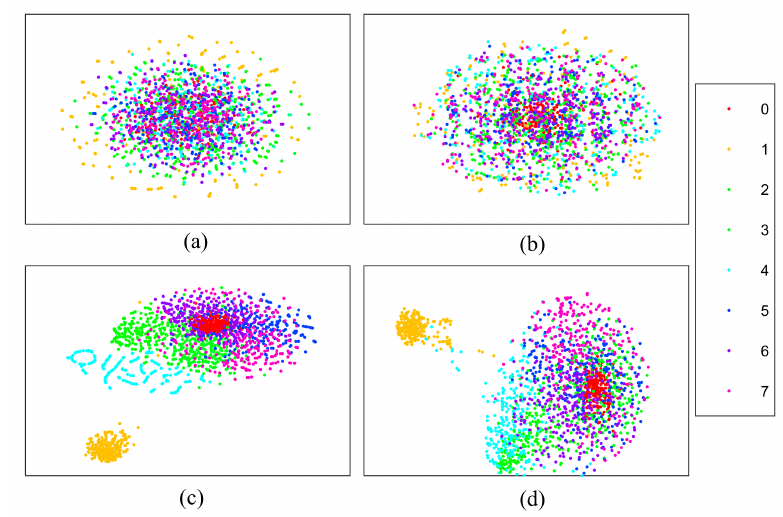
Figure 14. Feature visualization of di ff erent samples. ( a ) Feature visualization of raw samples; ( b ) Feature visualization of noisy samples; ( c ) Feature visualization of FFT samples; ( d ) Feature visualization of ESA